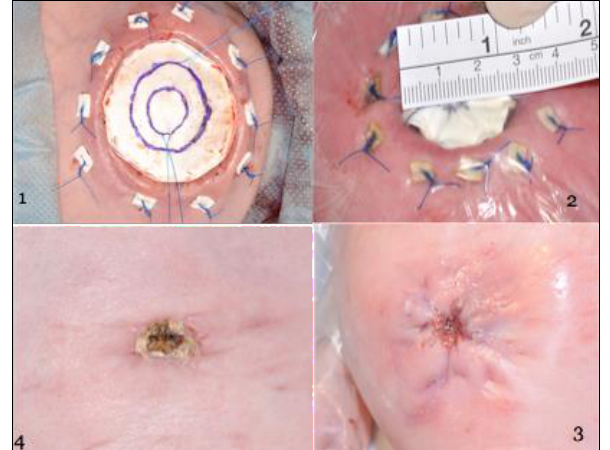
Figure 1-4: 1- The purse string sutures have been placed with care not to include the underlying bowel and the patch has been tied in place with felt pledgets to minimize the trauma to the tissues. 2- Appearance after the tying of both prolene purse string sutures, patch 2.5 cm in diameter. 3- Appearance post fascial and skin closure. 4- Appearance 6 weeks